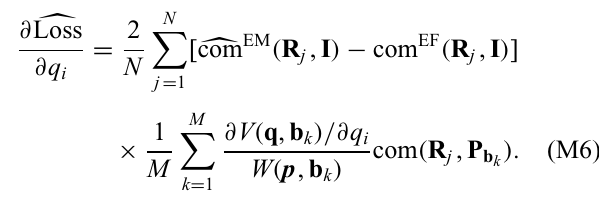
TABLE II. Learning rate used for different size circuits. Cir- cuit sizes of n qubits and N layers are represented in shorthand notation as n × N .